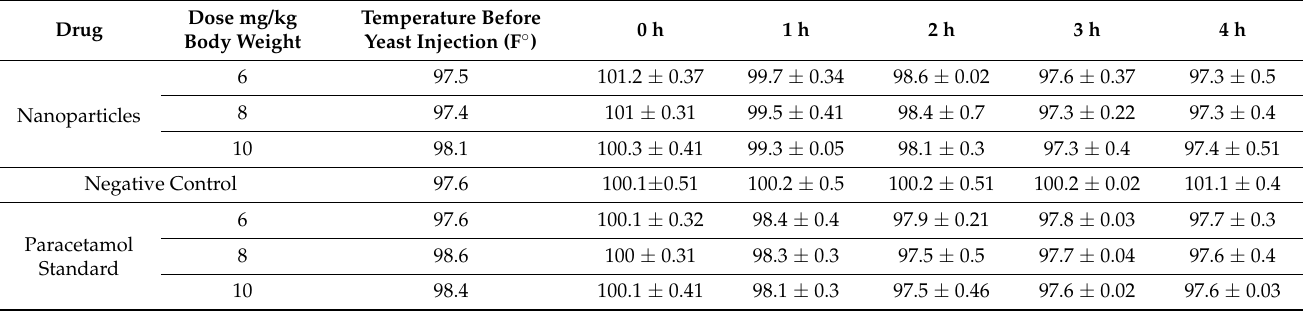
Table 8. Antipyretic effects of ZnO nanoparticles on yeast-induced pyrexia in